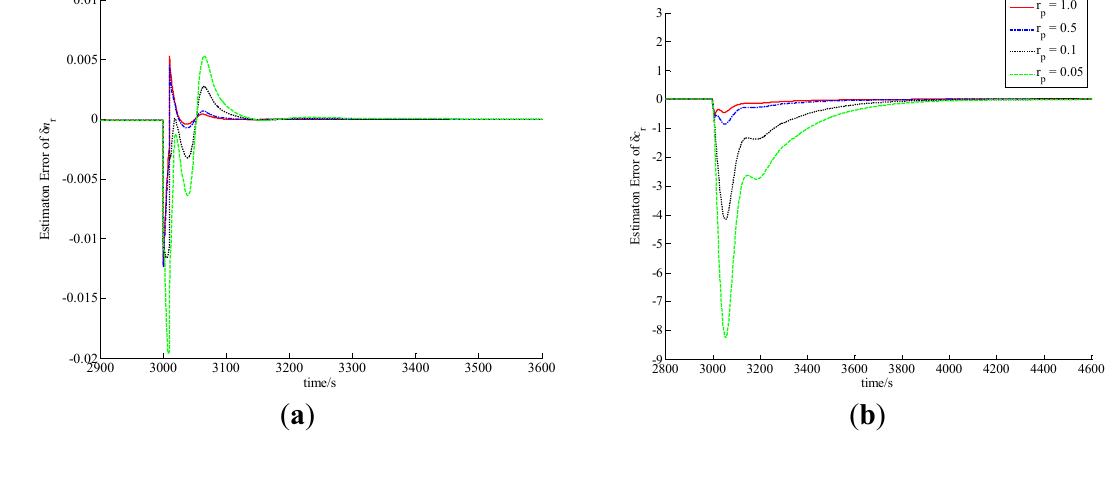
; ( b ) δ c ; ( c ) δ T and ( d ) δ T r r f